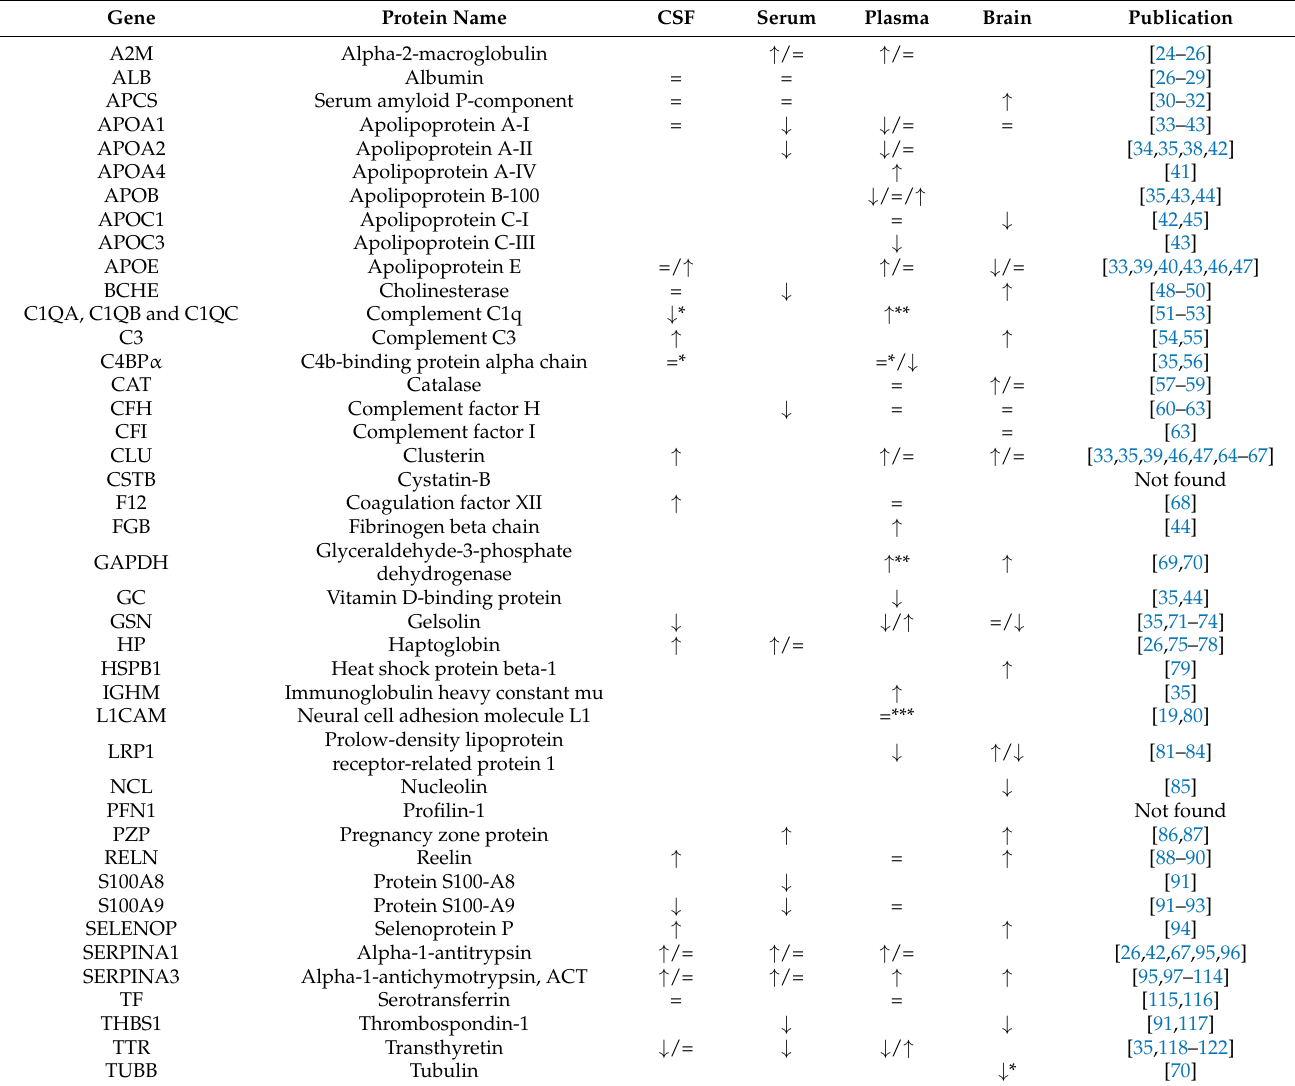
Table 1. A β -binding proteins found in the shared exosomal proteome and their expression tendency in AD. Gene and protein names of A β -binding proteins identified in the exosomes isolated from CSF, serum and plasma are indicated in the table, as well as the respective alterations reported in